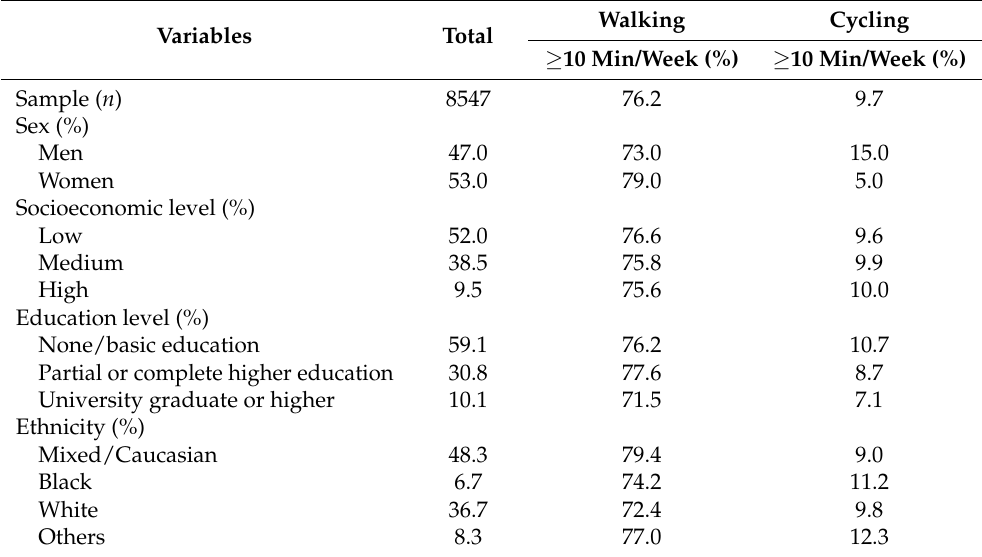
Table 2. Sociodemographic characteristics and active transportation in overall.